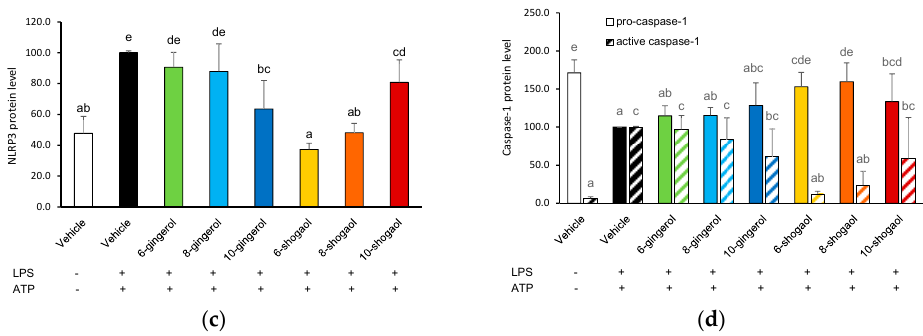
Figure 3. Effect of ginger phytochemicals on the protein levels of pro-IL-1 β ( b ), NLRP3 ( c ), pro-caspase-1 ( d ) and active caspase-1 ( d ) in LPS-primed and ATP-activated THP-1 macrophages. The panels show a representative photogram of immunoblotting ( a ) and the quantitative results of pro-IL-1b ( b ), NLRP3 ( c ) as well as pro-caspase-1 and active caspase-1 ( d ), respectively. The PMA-differentiated THP-1 macrophages were treated with ginger phytochemicals (20 µ M) for 1h, primed with LPS for 4h and then activated with 5 mM ATP for 3 h. Cytosolic proteins were subjected to determine protein levels of pro-IL-1 β , NLRP3, pro-caspase-1 and active caspase-1 by immunoblotting. Data are expressed as the mean ± SD of triplicate independent experiments. Values with different superscript letters are significant different from one another ( p < 0.05).